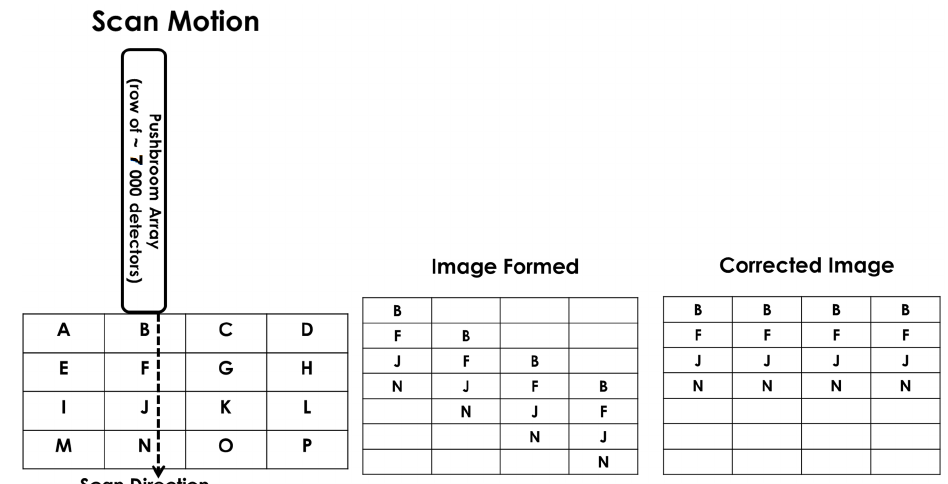
Figure 5. Side slither being performed ( left ); shifted image formed from scan line error ( middle ); pixel-shifted image ( right